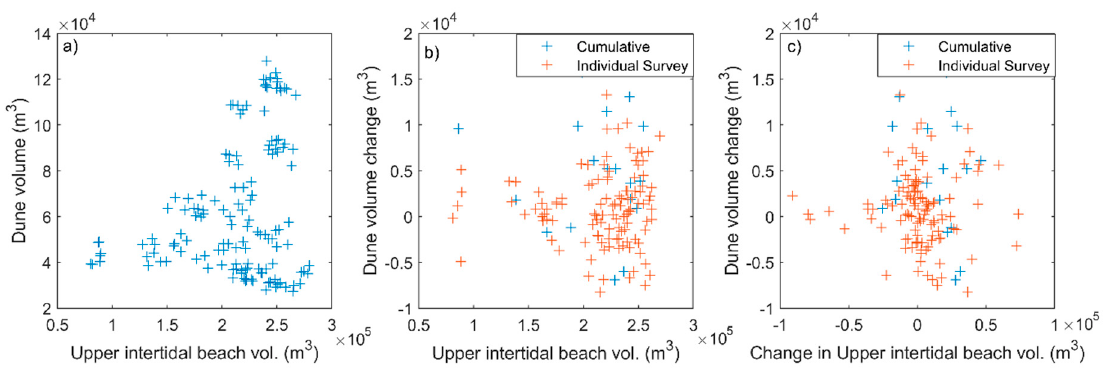
Figure 10. Scatter plots of: ( a ) dune volume against beach volume above MSL; ( b ) dune volume change against beach volume above MSL; ( c ) dune volume change against beach volume change. For panels b&c, both change between individual surveys and cumulative change is presented.